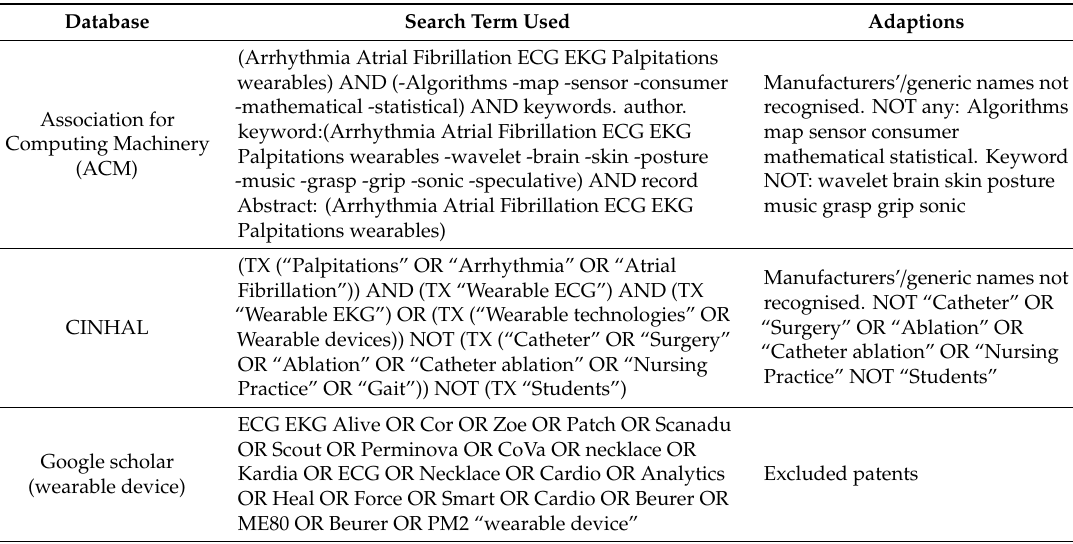
Table 2. Databases searched, search terms used, and adaptations